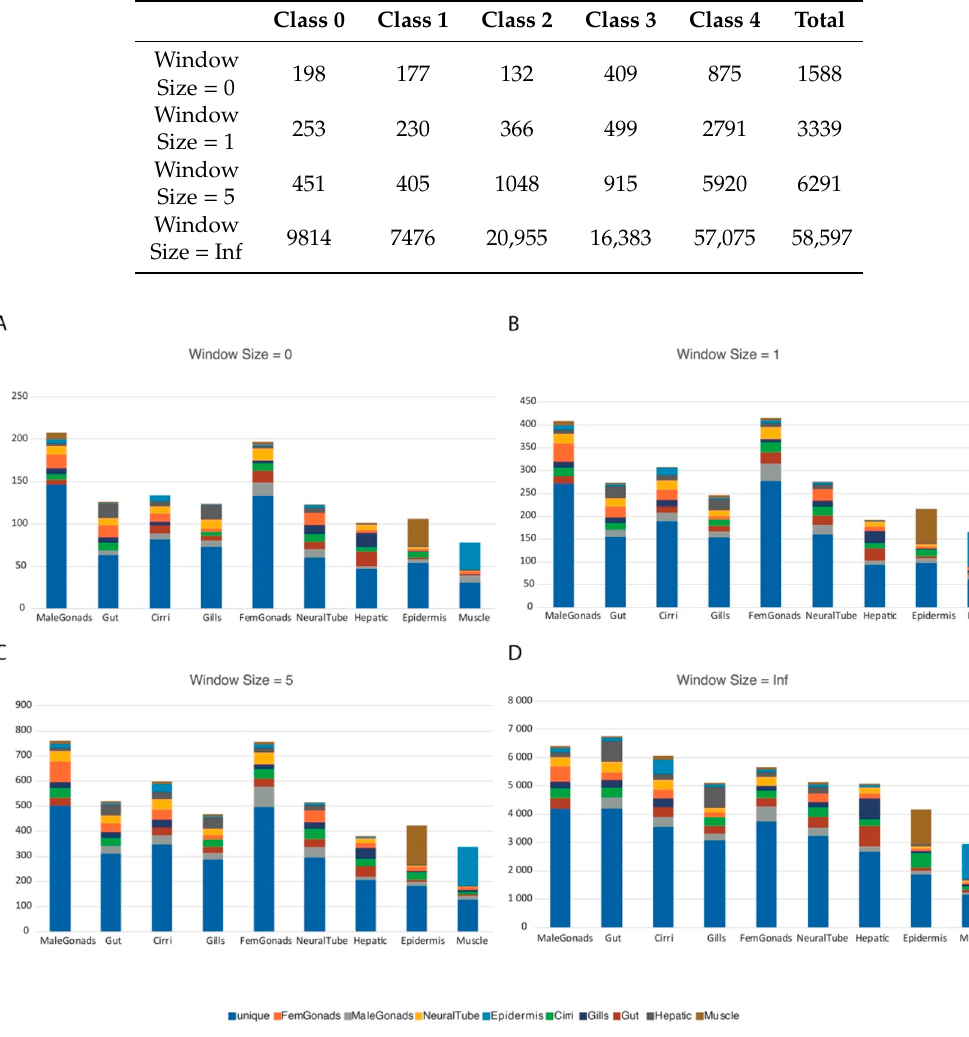
Figure 4. Putative orthologous RNA-editing events by tissue using the tested window sizes. Number of putative orthologous RNA-editing events by tissue, specific for one or two of the available tissues; each graph corresponds to one of the four window sizes analyzed: ( A ) Window size 0; ( B ) Window size = 1; ( C ) Window size = 5; ( D ) Window size =